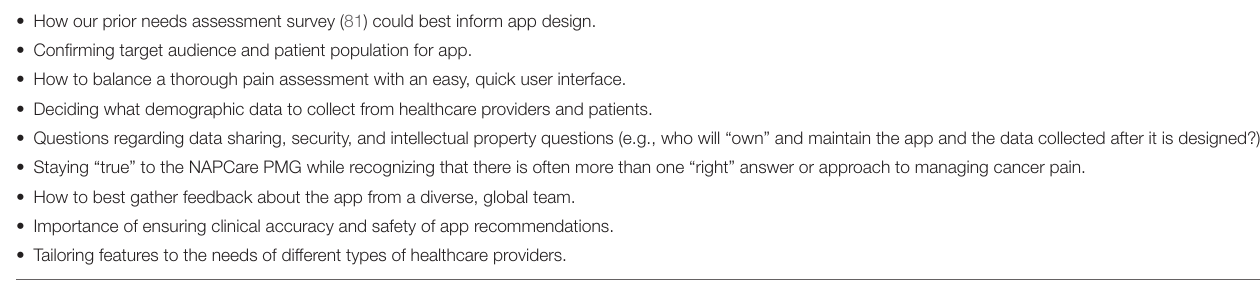
TABLE 1 | Key considerations related to the NAPCare mobile app design and development.